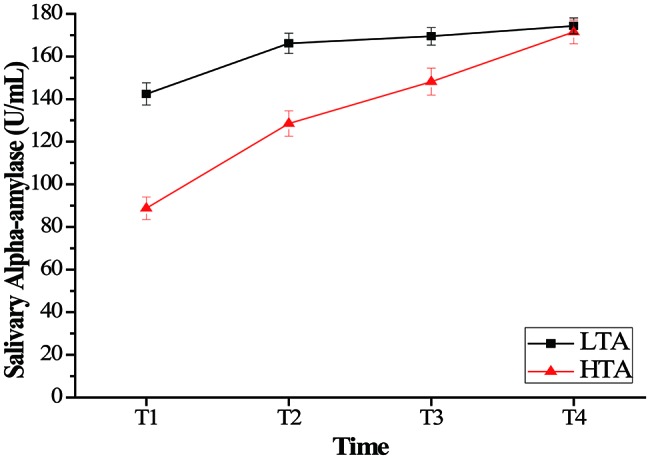
Mean salivary cortisol (nmol/L) as a function of time (minutes following intervention onset) for the stress. Error bars represent standard errors of the means.